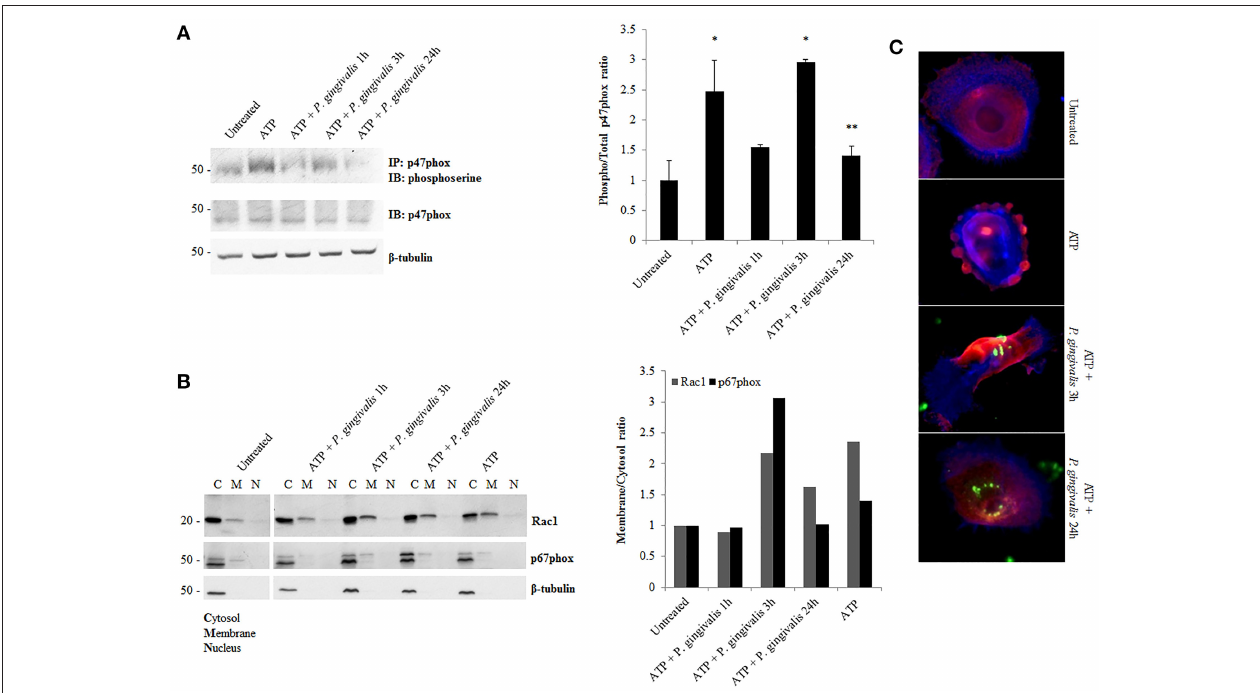
FIGURE 5 | P. gingivalis decreases critical NOX2 subunits activation and rearranges subcellular localization. (A) Phosphoserine immunoblot of immunoprecipitated p47phox in P. gingivalis (MOI100) infected primary GECs with ATP (3 mM) pre-treatment. Quantification of phosphorylated p47phox using NIH Image J Analysis. N = 3, * p < 0.05 ATP and ATP with 3 h P. gingivalis infection as compared to untreated; ** p < 0.05 ATP with 24 h infection decrease as compared to ATP with 3 h infection. (B) Subcellular Fractionation of cytosolic, membrane and nuclear fractions in P. gingivalis (MOI100) infected and ATP (3 mM) pre-treated cells. Western blot probing for Rac1 and p67phox in primary GEC fractionated lysates. Quantification of Rac1 and p67phox using NIH Image J Analysis. N = 3, normalized to beta-tubulin. (C) Epifluorescent micrographs of immunofluorescence localization of Rac1 (red) in P. gingivalis (green) (MOI100) infected cells. Blue phalloidin staining to outline cellular structure. 20x magnification images on Zeiss Axio